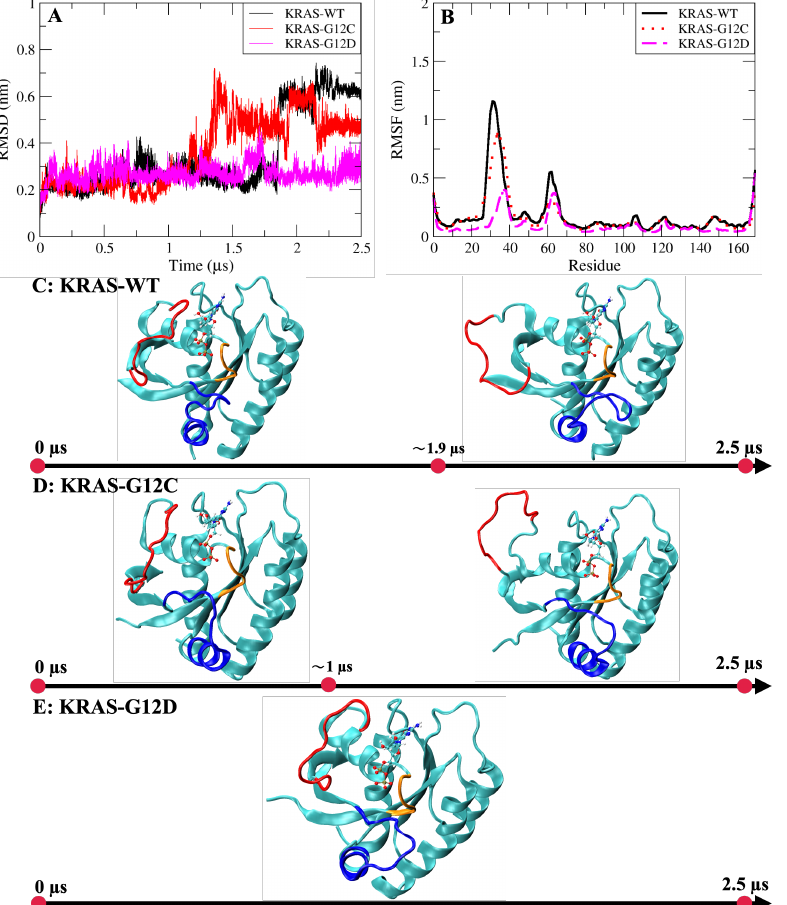
Figure A3. ( A ) Comparison of RMSD values of three KRAS proteins; ( B ) comparison of RMSF values of three KRAS proteins; ( C ) the evolution of KRAS-WT conformational changes; ( D ) the evolution of KRAS-G12C conformational changes; ( E ) the evolution of KRAS-G12D conformational changes. Red: Switch-I; blue: Switch-II; orange: P-loop. Water and ions have been